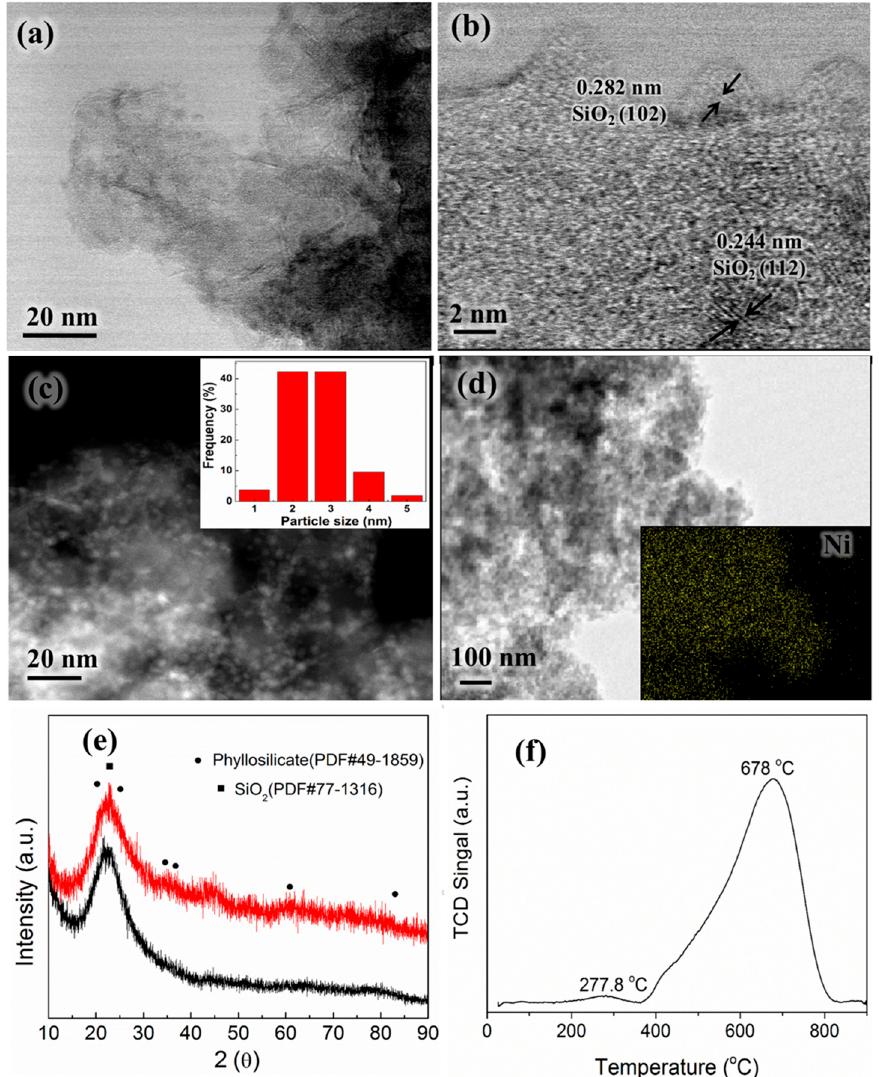
Figure 2. HRTEM (high-resolution transmission-electron microscopy) images of ( a , b ) Ni/SiO 2 , ( c ) HAADF-STEM (high-angle annular dark field scanning transmission electron microscopy) images and Ni particle-size distribution (inset) for Ni/SiO 2 , ( d ) SEM (scanning-electron microscopy) image of Ni/SiO 2 and Ni mapping (inset), ( e ) XRD (X-ray powder diffraction) patterns of SiO 2 and Ni/SiO 2 , ( f ) H 2 temperature-programmed reduction (H 2 -TPR) of catalyst NiO/SiO 2 .